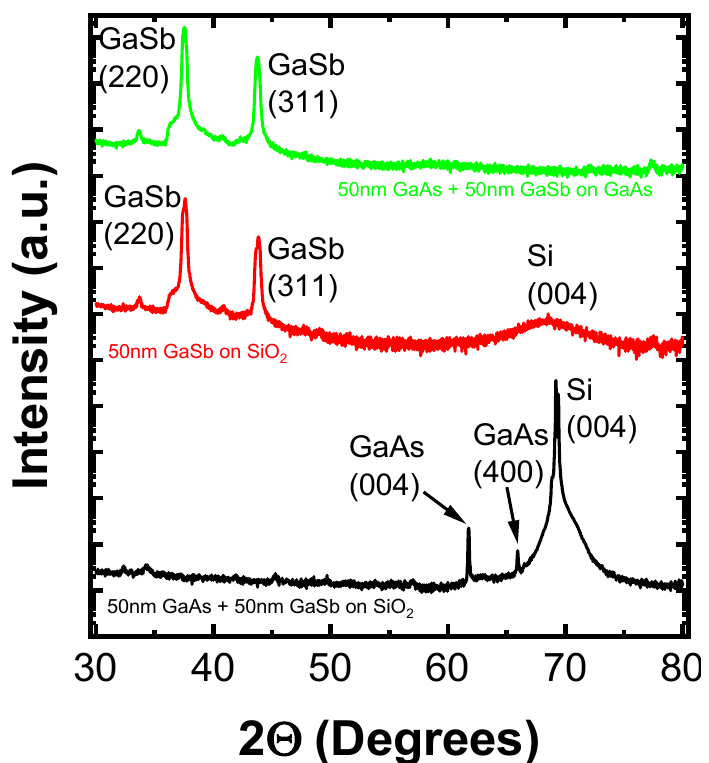
Figure 3. XRD of 50 nm GaAs + 50 nm GaSb on SiO 2 , 50 nm GaSb on SiO 2 , and 50 nm GaAs + 50 nm GaSb on GaAs.